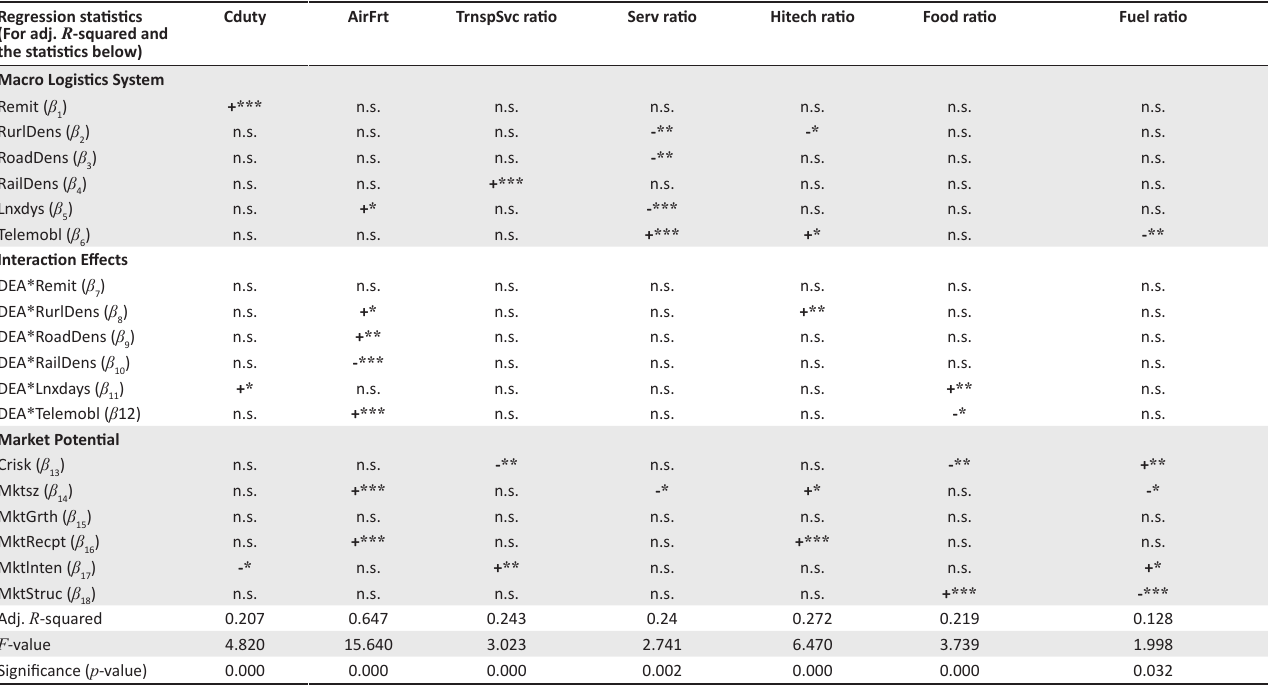
TABLE 6: Regression results for Equation 2 * . Regression statistics (For adj. R -squared and the statistics